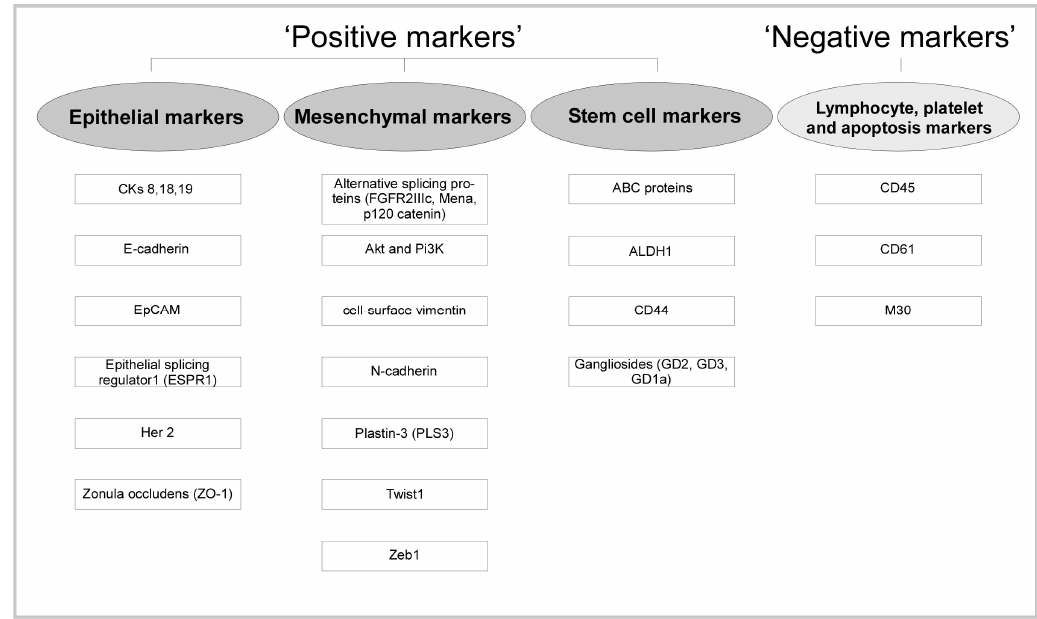
Figure 2. Illustration of CTCs detection specific key biomarkers.